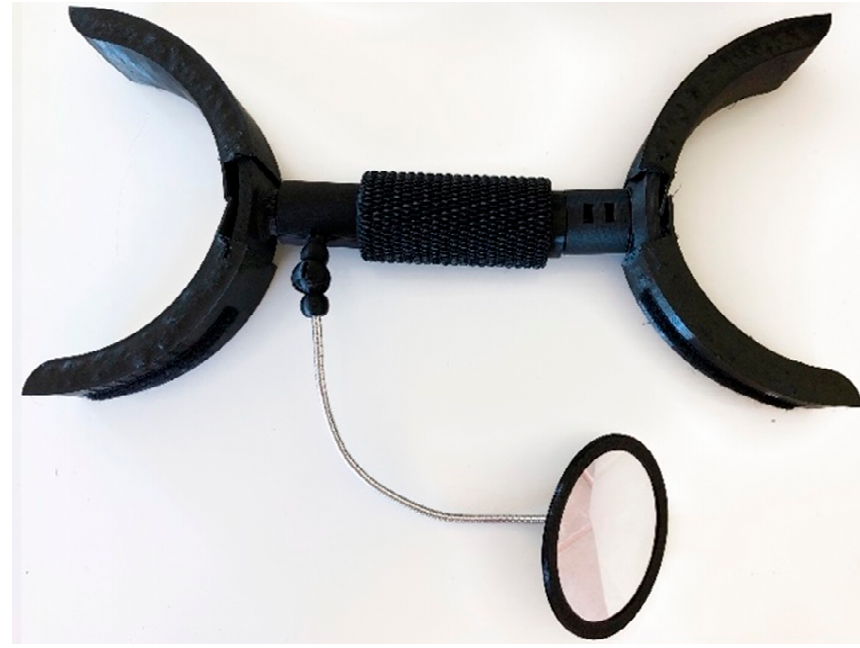
Figure 7. Mechanical device with the mirror system coupled.